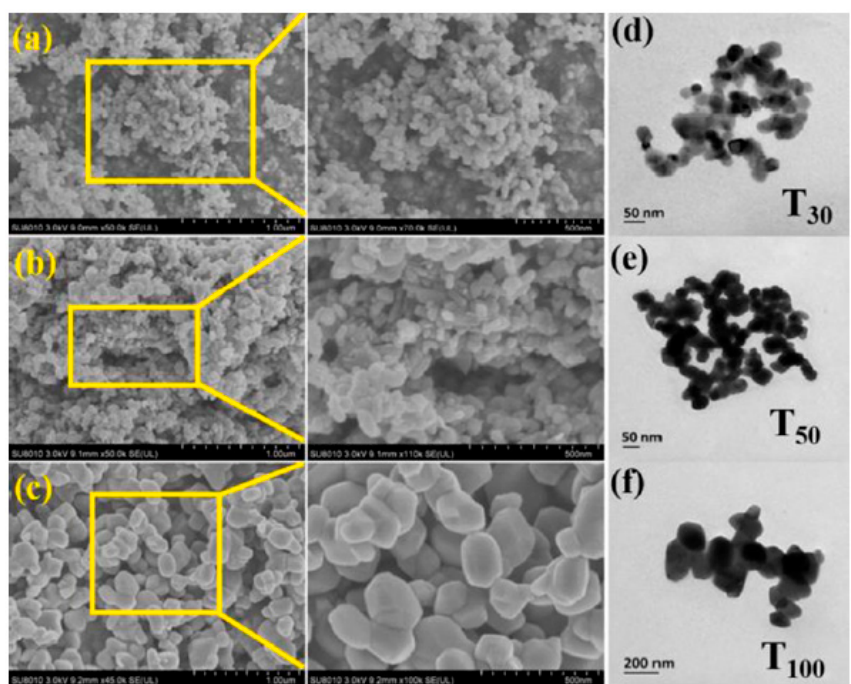
Figure 10. Surface morphology of alkali-activated specimens containing various level of nano-titanium ( a , d ) T30 ( b , e ) T50 and ( c , f ) T100 [179].